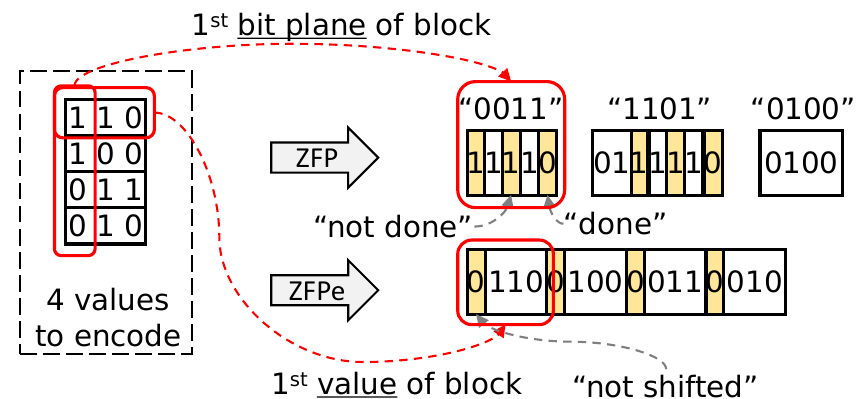
Figure 2. ZFP and ZFPe encoding three-bit planes of four